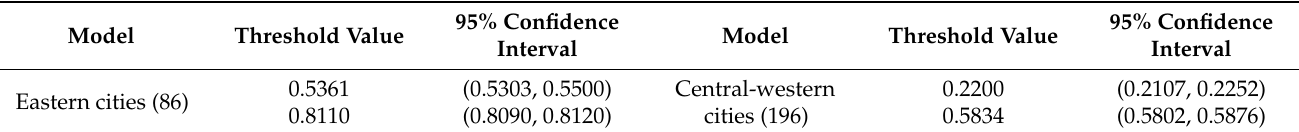
Table 6. Estimated results of the environmental regulation